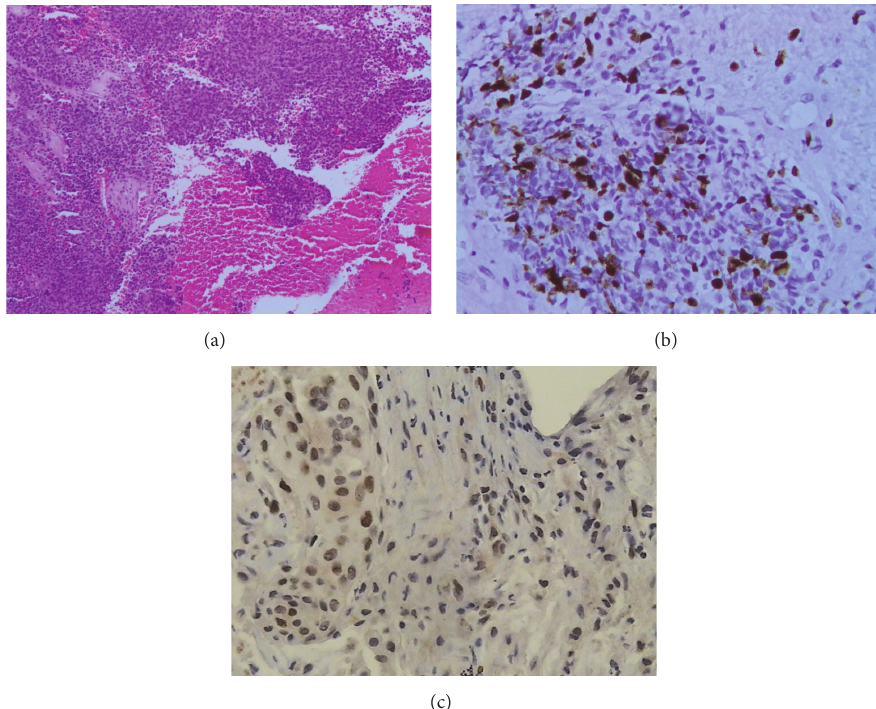
Figure 2: (a) HE staining of the pituitary macroadenoma tissue confirming atypical pituitary adenoma (magnification × 100). (b) Ki-67 positivity in tumor tissue of 10–20% (magnification × 400). (c) p53 positivity in less than 5% of cells (magnification ×